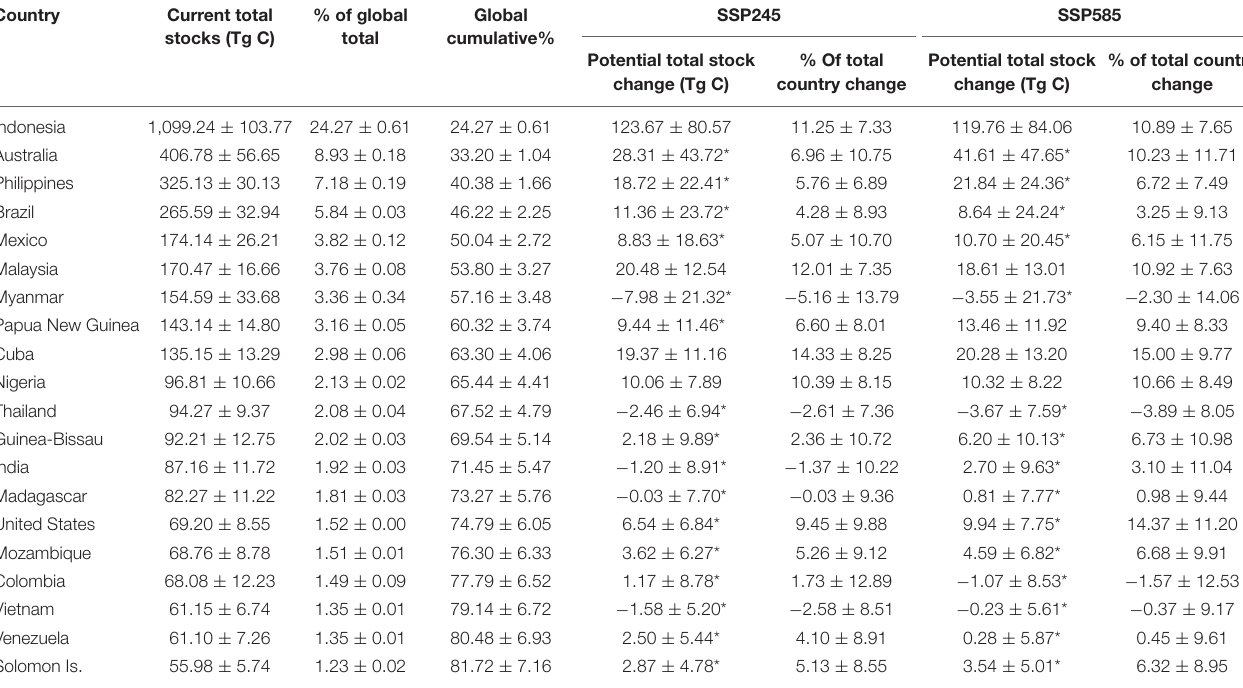
TABLE 1 | Mean ± 2 standard errors mangrove C stocks held by the 20 most mangrove-rich countries, and their forecasted gains under two climate scenarios (SSP245 and SSP585) based on bias-corrected and means-weighted forecasted climate data. Country Current total stocks (Tg